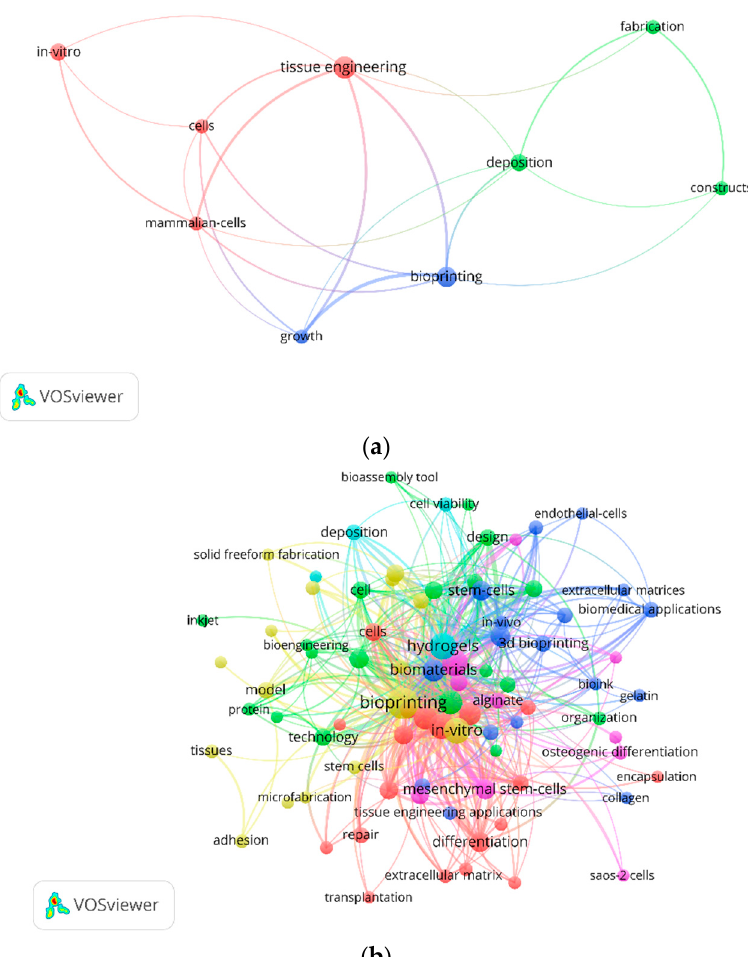
Figure 3. Temporal evolution of keyword co-occurrence networks between 2006 and 2016 with a time interval of 5 years, ( a ): 2006–2010; ( b ): 2011–2015. The size of each node is proportionate to its degree and the thickness of the links represents the tie strength.